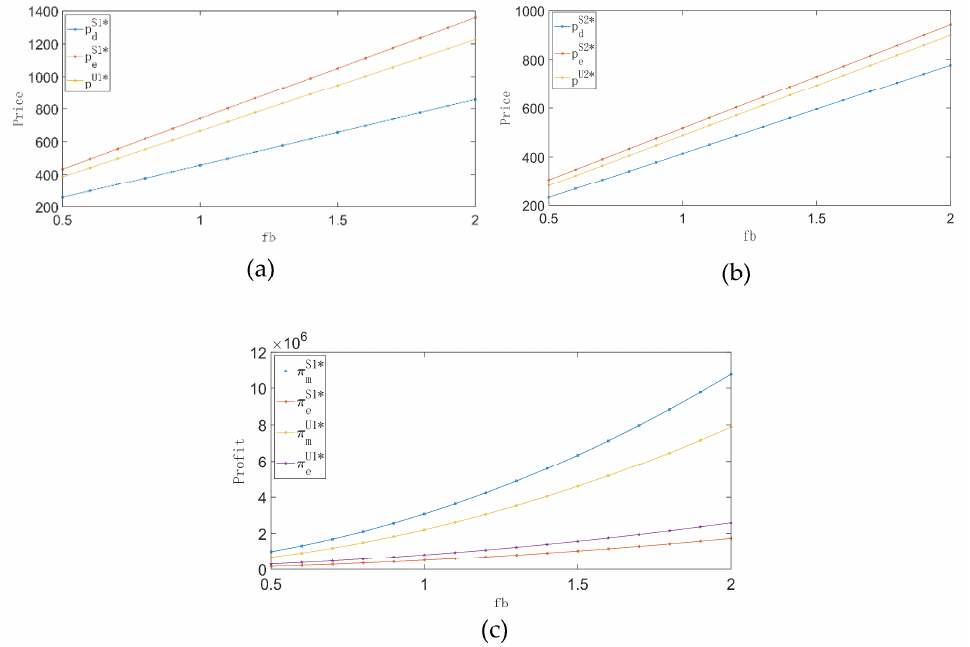
Figure 4. The impact of customer benefit perception f b on equilibrium results. ( a ) The impact of f b on sales price under the decentralized decision-making. ( b ) The impact of f b on sales price under the centralized decision-making. ( c ) The impact of f b on profits of two parties under the decentralized decision-making.